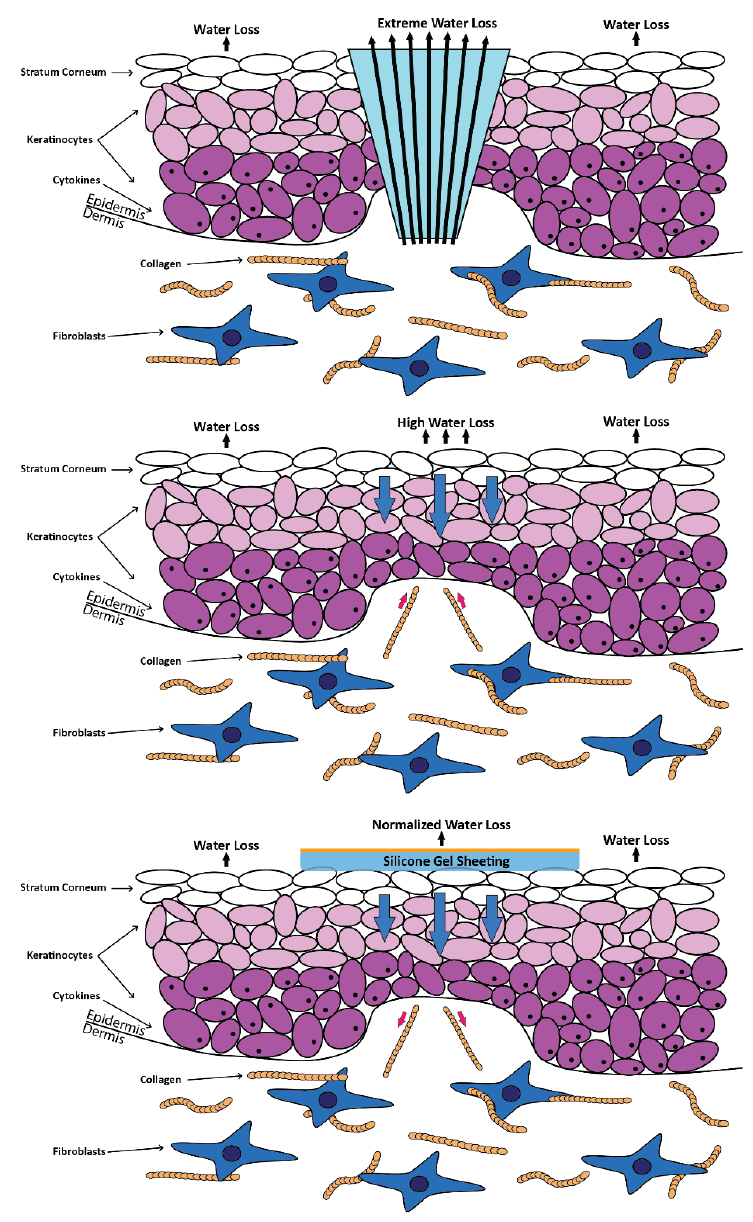
Figure 5. Application of silicone gel sheeting on top of the wound. The image was redrawn with a slight modification using Illustrator in reference to the figure from Bleasedale et al. [39].